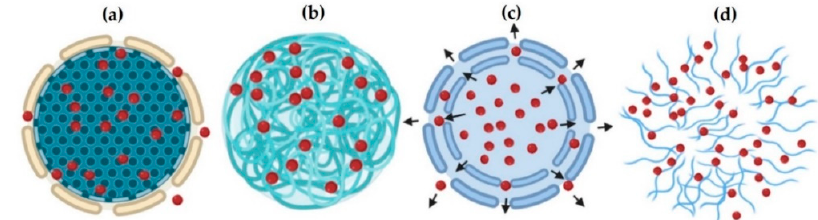
Figure 4. Mechanisms of release of active principles by polymeric nanocarriers. ( a ) Di ff usion through water-filled pores. ( b ) Di ff usion through the polymeric matrix. ( c ) Osmotic pumping. ( d ) Erosion and degradation of polymeric matrix caused by hydrolysis or for external